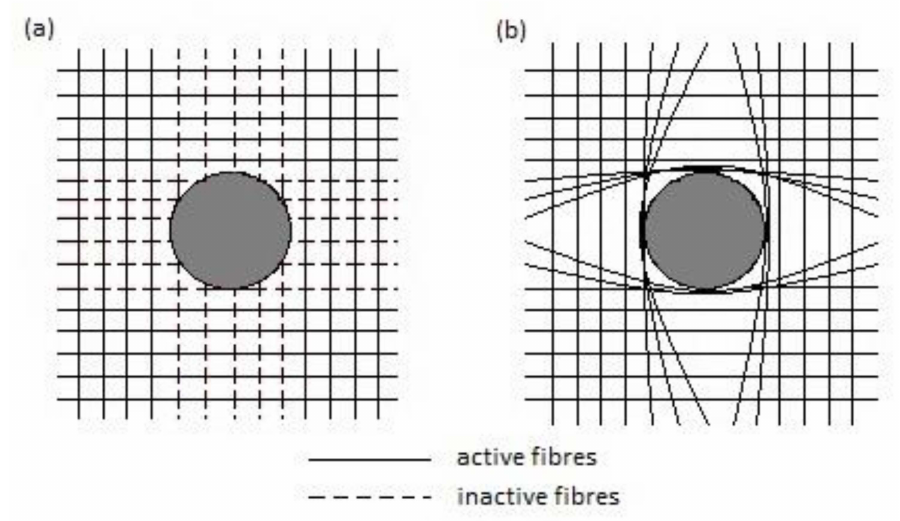
Figure 25. Load-bearing fibres for composites with ( a ) drilled hole and ( b ) moulded